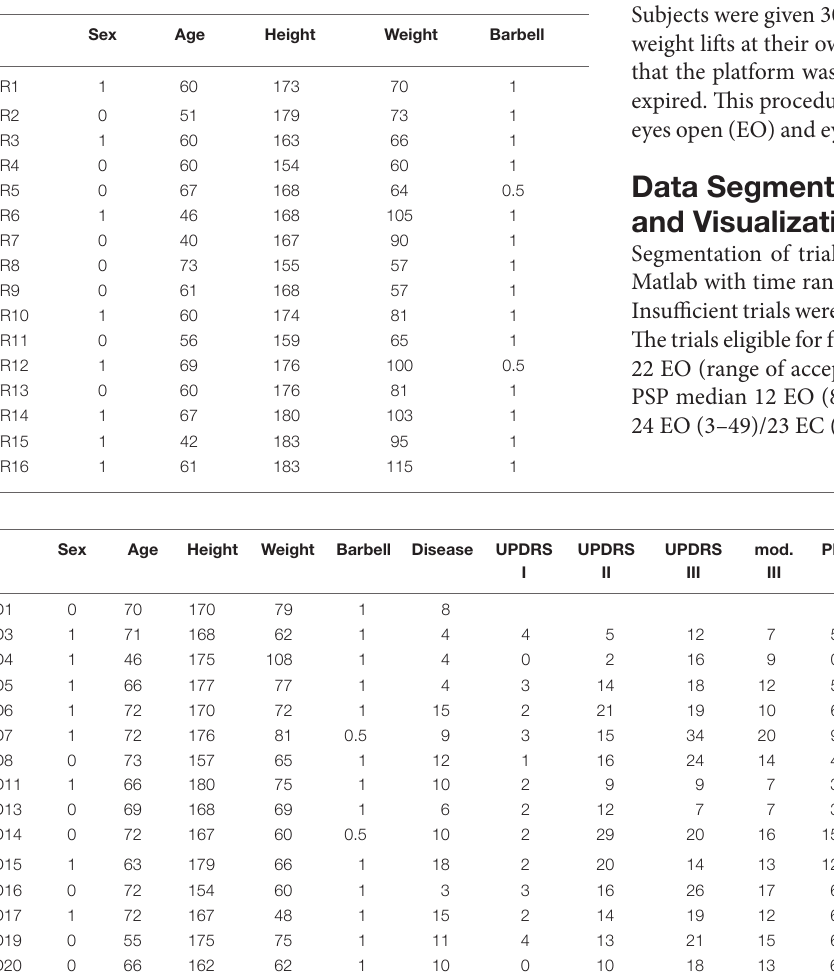
TaBle 1 | Clinical parameters of participants in this study: (a) controls subjects (CTR), (b) idiopathic Parkinson’s disease (IPD), and (c) progressive supranuclear palsy (PSP) are shown with sex (0 female, 1 male), age (median ± SD: CTR 60 ± 9.4, IPD 70 ± 7.5, PSP 68 ± 3.6), height in cm, barbell (weight of adjustable instrument, either 0.5 kg or 1 kg), disease duration (YEARS diagnosed with disease in IPD median ± SD 10 ± 4.5 and months in PSP 5 ± 6.4) and clinical scores; Unified Parkinson’s Disease Rating Score (UPDRS) with items I, II, III (median ± SD: IPD 18.5 ± 6.9, PSP 13 ± 3.2) and modified III (scaled each question/task 0–4), PIGD, Hoehn & Yahr Scale (H&Y under optimal